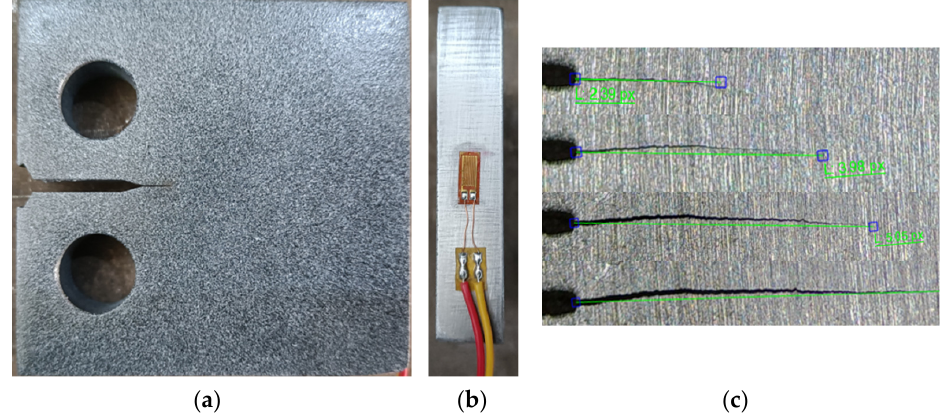
Figure 3. CT specimen: ( a ) speckle pattern, ( b ) back strain gauge, ( c ) crack observation.